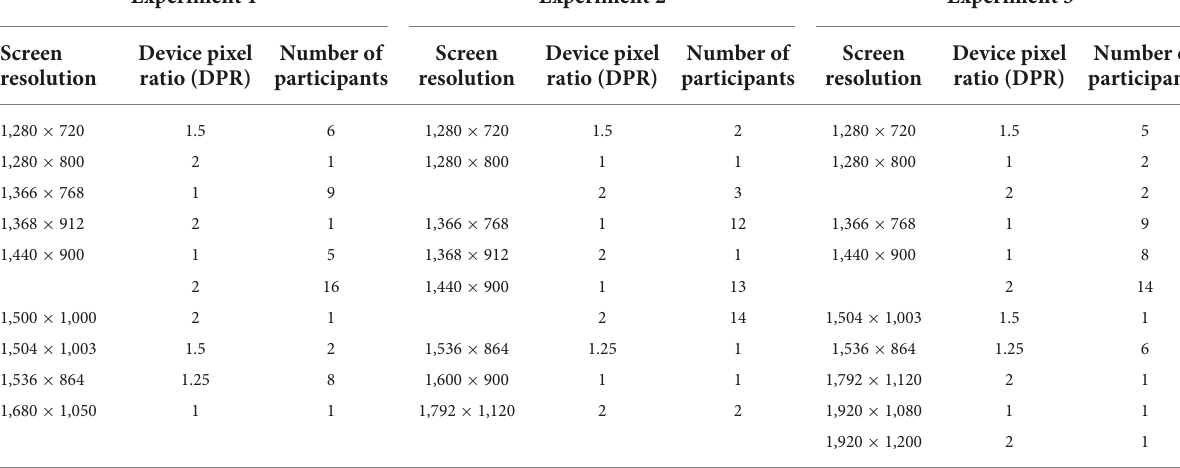
TABLE 2 Screen resolution (logical pixels) and device pixel ratio